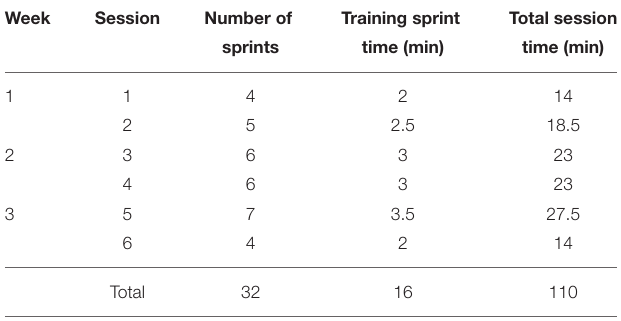
TABLE 4 | Sprint interval training distribution over 3